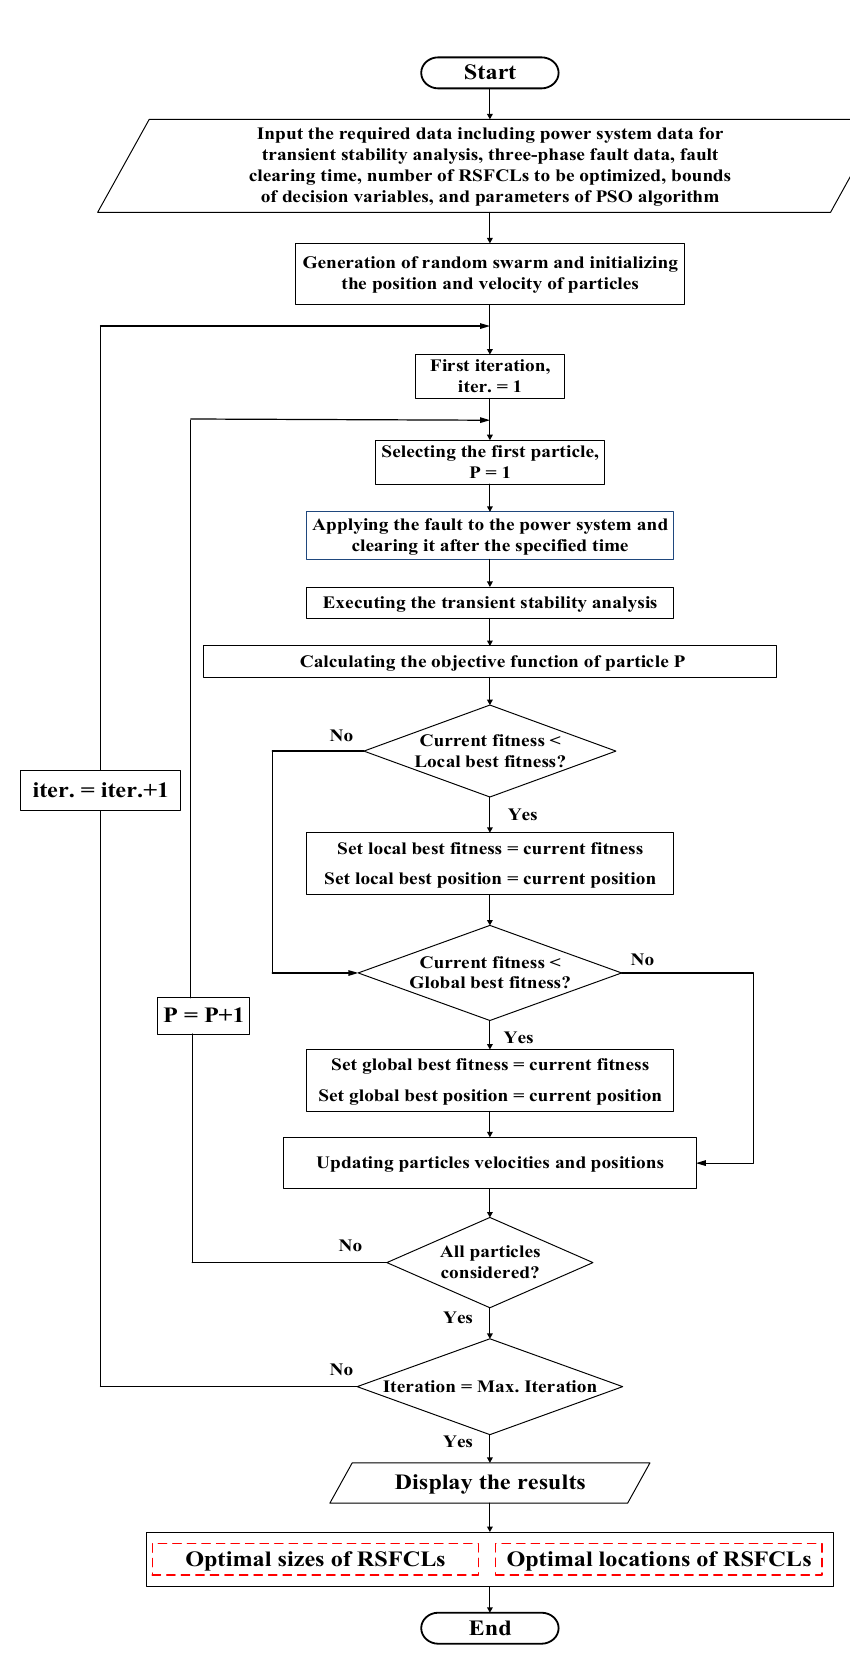
Figure 6. Optimization procedure of RSFCLs sizing and allocation using PSO.